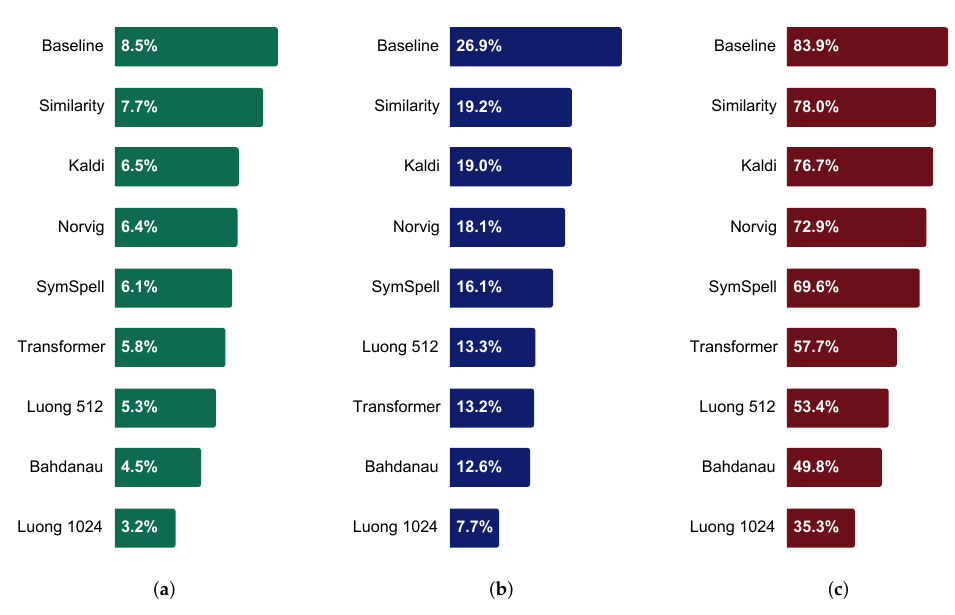
Figure 10. Error rates summary (lower is better), ( a ) Character Error Rate (CER); ( b ) Word Error Rate (WER); ( c ) Sequence Error Rate (SER).